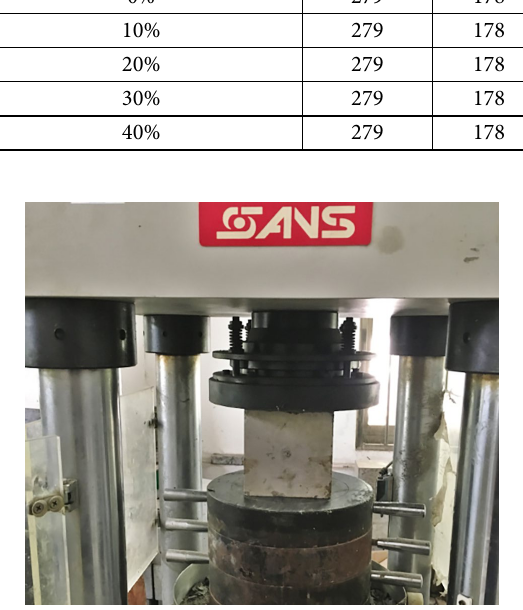
Figure 1. Compressive loading equipment